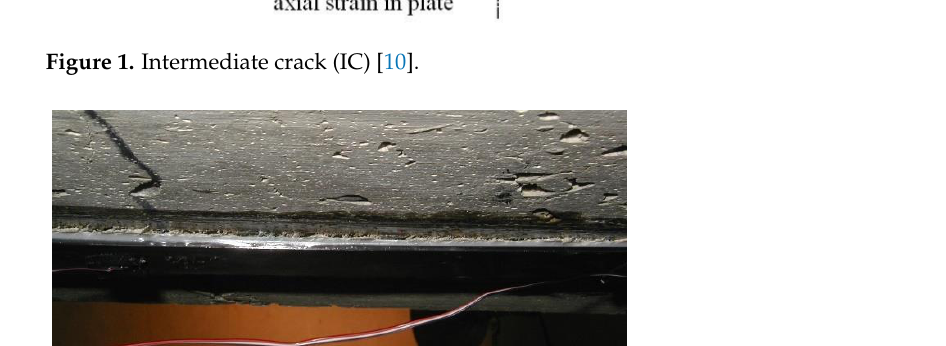
Figure 2. Localized debonding of FRP reinforcement in maximum moment region [11].